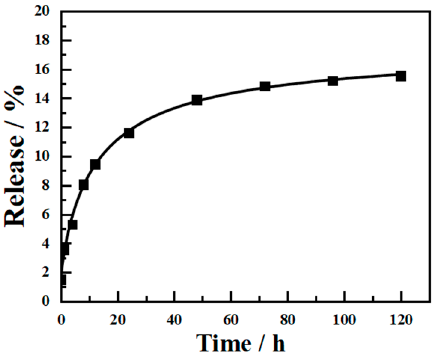
Figure 8. Release curve of gallate anion in 3.5 wt.% NaCl solution.